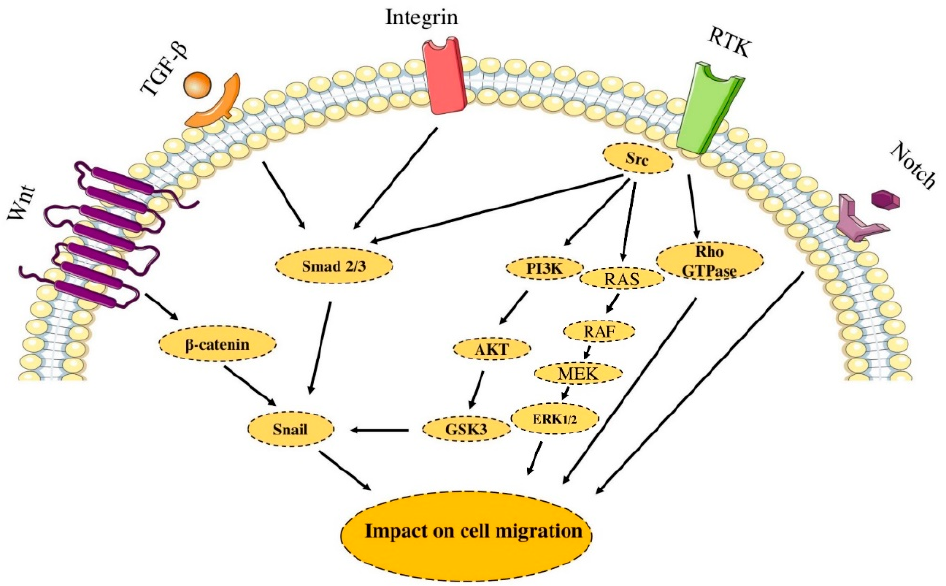
Figure 4. Signaling pathway and cell migration. Metastasis is a multistep process that includes migration and invasion of cancer cells. Migration is regulated by adhesion receptors, chemokines, growth factors, and other stimulators. The figure was produced using Servier Medical Art (http://smart.servier.com/) (assessed on 2 January 2020).